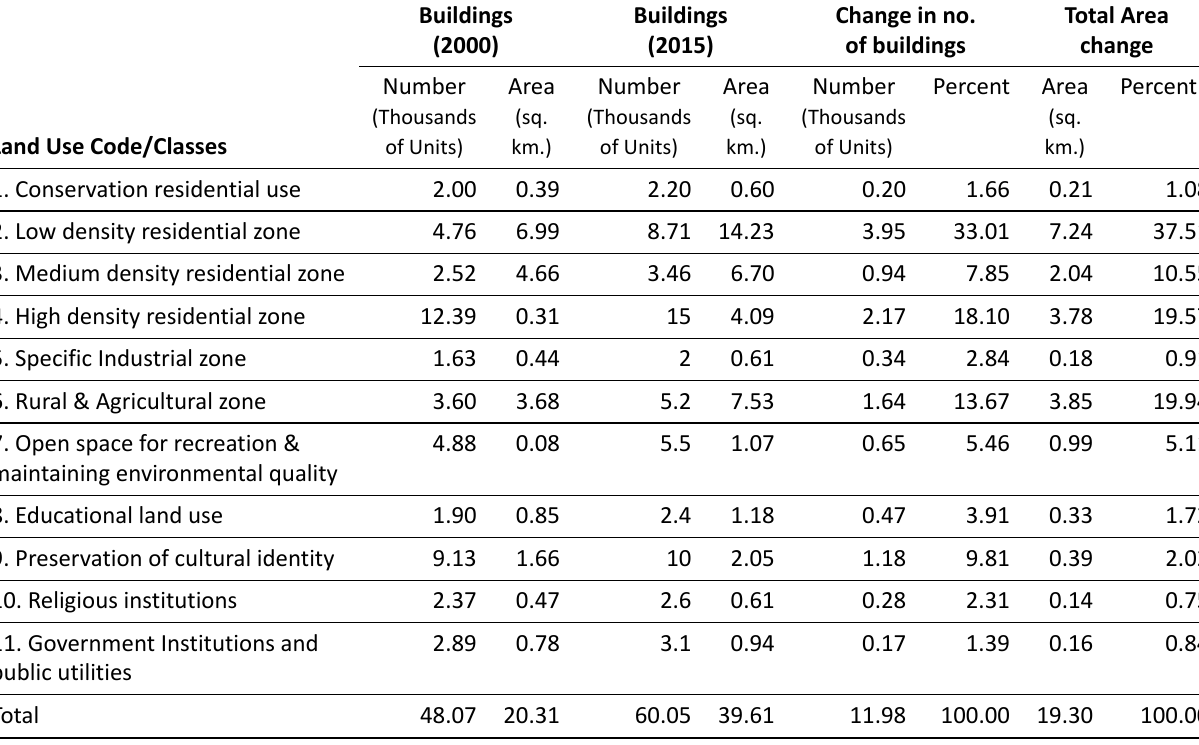
Table 2. Land Use Changes in the Comprehensive Plan Boundary by Zones between 2000–2015. Data reveals that 20% of recent building construction within the comprehensive boundary area has been in agricultural preservation zone. (Sanga- wongse & Vittaya,